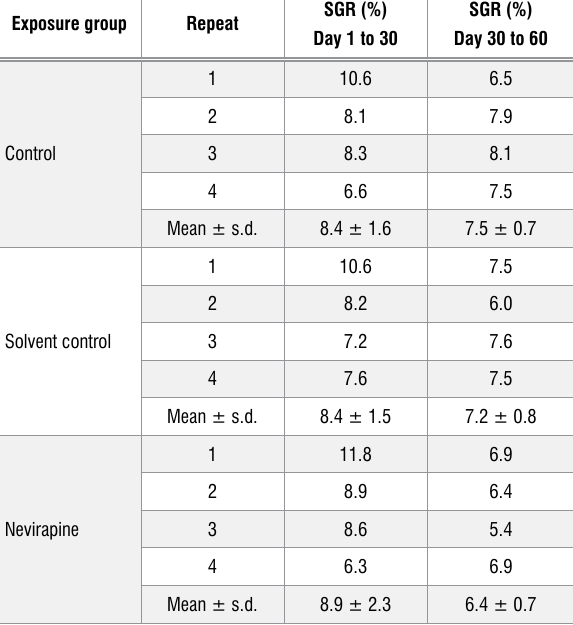
Table 2: Specific growth rate (SGR) of fish in the three exposure groups from Day 1 to Day 30 and from Day 30 to Day 60 post-hatching Exposure group